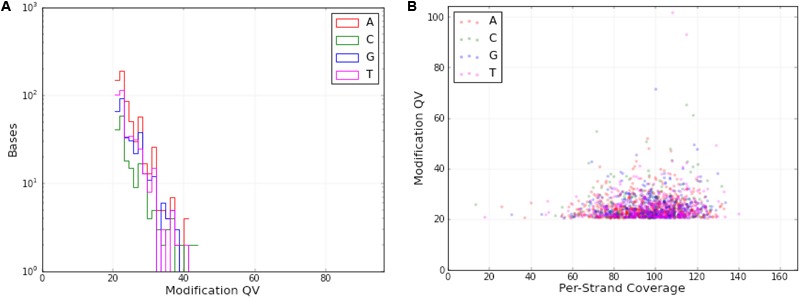
DNA modifications in the O. sinensis mt genome. (A) Distribution of the number of DNA modification bases with different modification quality value (QV). (B) Scatter plot of the DNA modifications with different per-strand coverage. At each genomic position, modification QV were computed as the –10 log (P-value) for representing a modified base position, based on the distributions of the kinetics of interpulse durations (IPD ratios) from all reads covering this position and from in silico kinetic reference values. Each dot represents a position on either strand with a modQV larger than 20. The color specified the nucleotide base, on which the modification was detected. Adenosines were colored in red, guanosines were colored in green, cytimidines were colored in blue, and thymines were colored in purple.